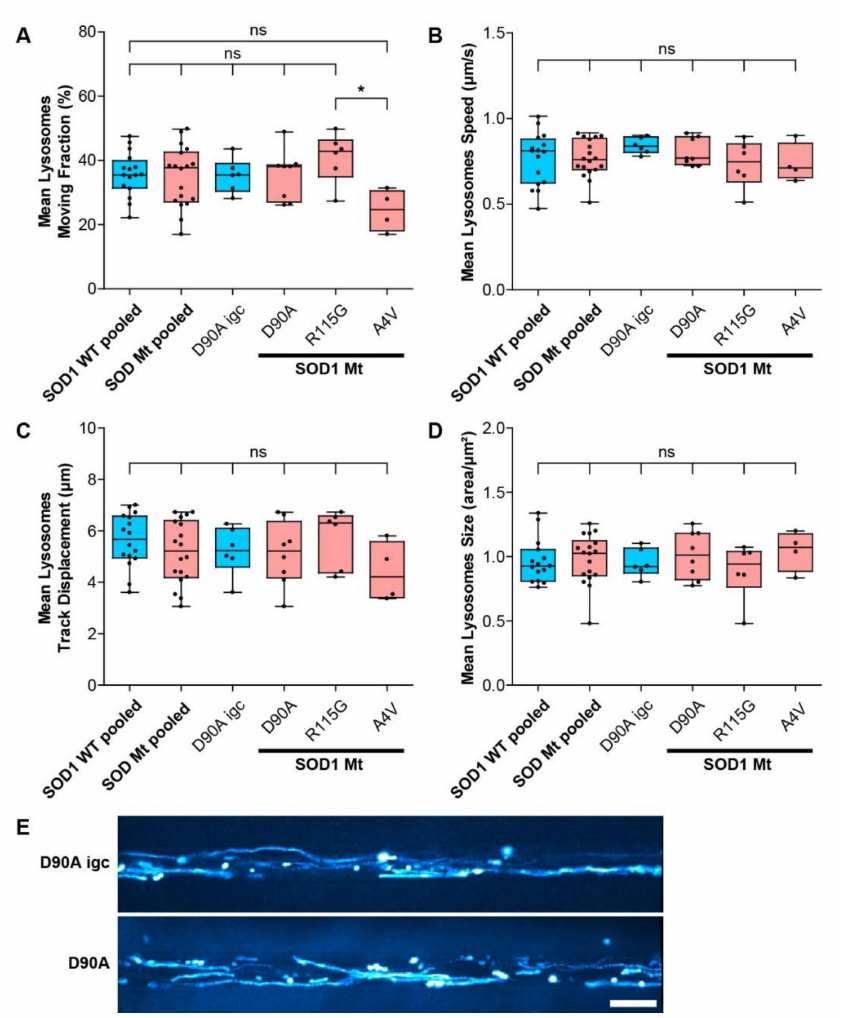
Figure 6. Lysosomal size and motility was not altered in mutant SOD1 spinal MNs. ( A – D ) Box plots of various tracking and morphological parameters deduced from moving lysosomes as mean values per experiment (black dots) for each respective line with 25–75% interquartile range (box), median (horizontal line) and non-outlier range (1.5-fold interquartile range added above and below to box, whiskers). SOD wildtype pooled: data from all SOD wildtypes lines including D90A igc ( n = 6) were pooled ( n = 13) as listed in Table 1. SOD mutants pooled: data from D90A ( n = 13), R115G ( n = 4), and A4V ( n = 4) (Table 1) were pooled ( n = 21). Ns: no significant change in any pairwise comparison of control cells (in blue) with mutant lines (in red), one-way ANOVA with Bonferroni post-hoc test. * p < 0.05, n.s. not significant. ( A ) Percentage of moving lysosomes, ( B ) lysosome mean speed, ( C ) track displacement, and ( D ) size in any SOD1 Mt lines was not altered compared to SOD1